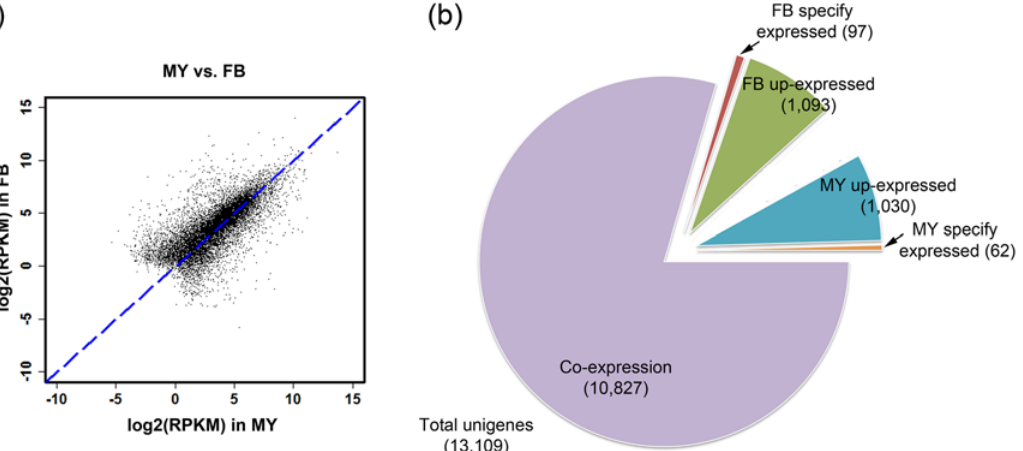
Fig 1. Differentially expressed gene analysis of wild-type fruiting bodies and liquid cultured mycelium of A . cinnamomea . F: wild-type fruiting bodies; M: liquid cultured mycelium. (a) Scatter plot of unigenes from A . cinnamomea RNA-seq. (b) Pie chart of the DEG distribution in wild-type fruiting bodies and liquid cultured mycelium. FDR < 0.05 and fold change (cid:1) 2 or (cid:3) 0.5 were defined as differential